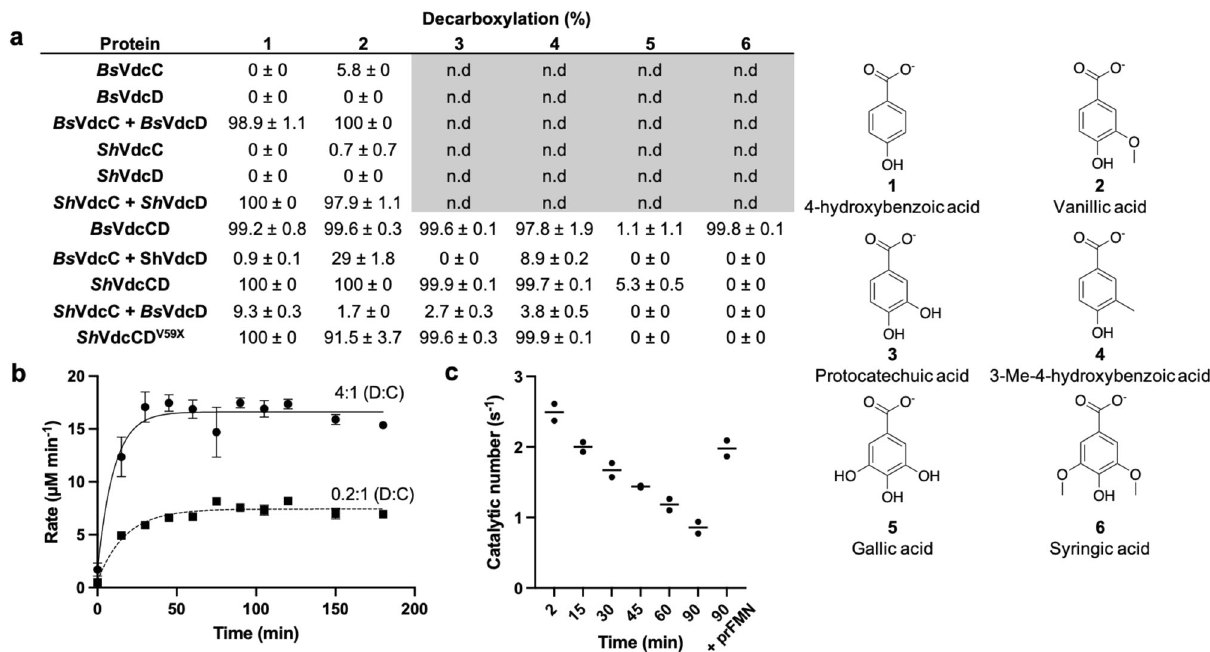
Fig. 2 Activity of Vdc proteins. a Activity of reconstituted Vdc proteins. Signi fi cant activity is only seen when both VdcC and VdcD are present. Protein obtained through co-puri fi cation is denoted as VdcCD. Where proteins were puri fi ed separately and combined in vitro, the label VdcC + VdcD is used. Substrate speci fi city of VdcCD enzymes from Bacillus subtilis and Sedimentibacter hydroxybenziocus show similar substrate ranges, with the exception of syringic acid. Non-cognate VdcD can be used for the limited activation of VdcC. Deletion of the proline rich tail of VdcD has little effect on the activity of VdcCD. Data shown as mean ± SEM n = 2 independent replicates. b Effect of VdcC:VdcD ratio on decarboxylation rates of 100 µ M PHB. A sub-equimolar ratio results in slower decarboxylation of PHB, suggesting a non-transient interaction between VdcC and VdcD. Data are represented by mean ± SEM, n = 3 technical replicates. Data trends seen in three independent replicates. c Decrease in activity of Sh VdcCD with 100 µ M PHB in aerobic conditions. Addition of prFMNH 2 partially restores activity, all data points shown, bar represents mean. Data from two independent replicates.